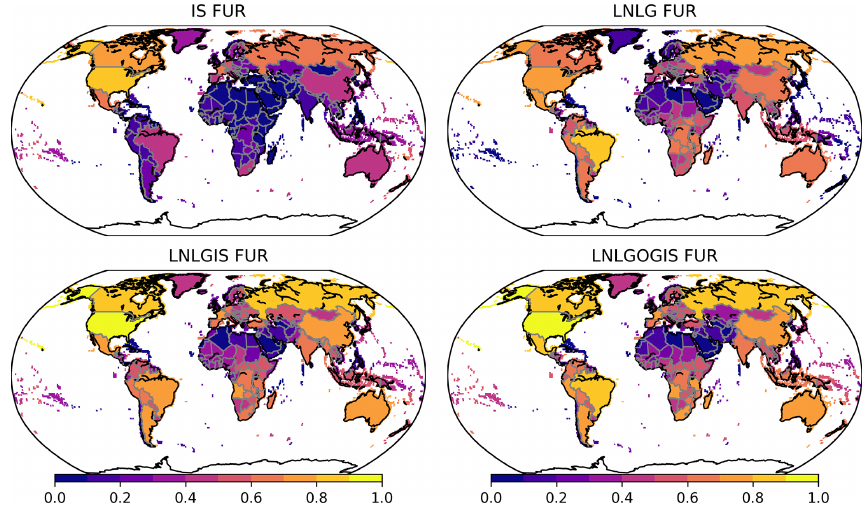
Figure 10. Estimate of the fractional uncertainty reduction (FUR) on the v10 OCO-2 MIP estimates for each experiment based on Bayesian uncertainty estimates from the TM5-4DVar